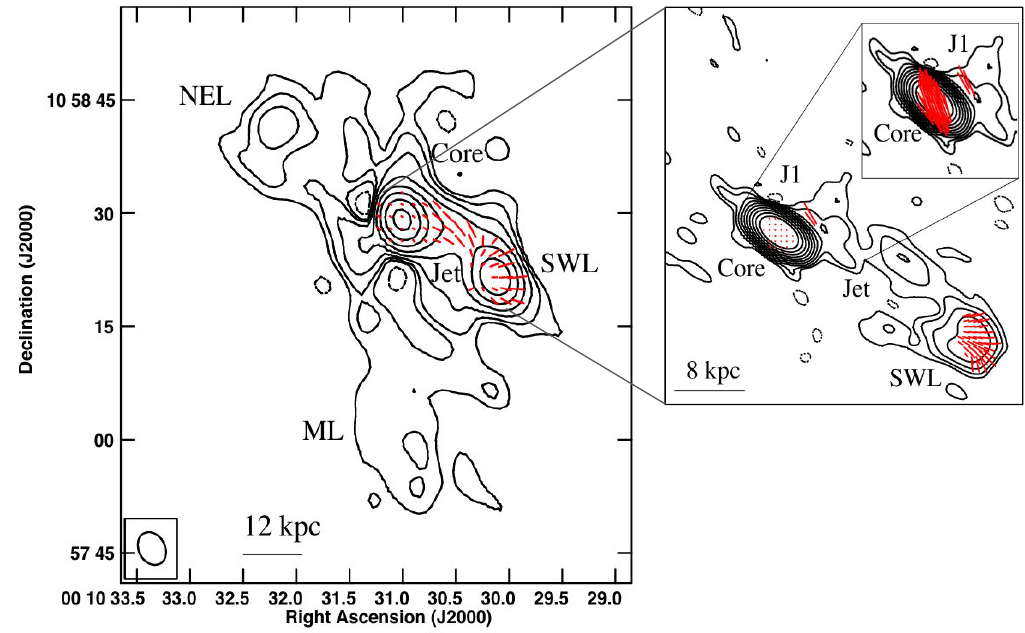
Figure 4. The GMRT 685 MHz total intensity contour image of IIIZw2 superimposed with red fractional polarization vectors, with 2 arcsec length of the vector corresponding to 6.25% fractional polarization. The inset on the right presents the VLA 5 GHz total intensity contour image of the south-western jet–lobe region, superimposed with red fractional polarization vectors, with 1 arcsec length of the vector corresponding to 25% fractional polarization. The smallest inset on the top right presents the VLA 5 GHz total intensity contour image of the radio core with red polarized intensity vectors, with 1 arcsec length of the vector corresponding to 0.031 mJy beam − 1 polarized intensity. The peak contour surface brightness is x mJy beam − 1 and the levels are y × ( − 1, 1, 2, 4, 8, 16, 32, 64, 128, 256, 512) mJy beam − 1 , where (x ; y) are (35, 0.21) and (124, 0.05) for the GMRT and VLA images respectively. Figure reproduced from Silpa et al.